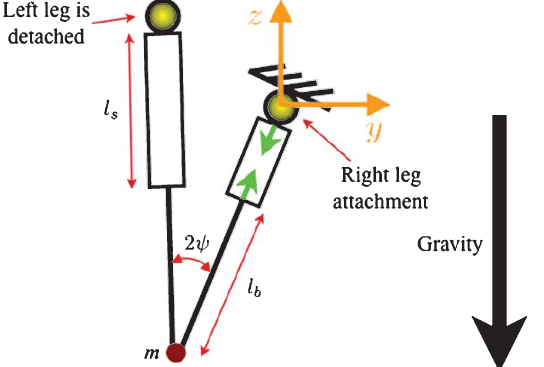
Fig. 1. Mid-stride for the body-switched model. The right foot is attached and serves as a frictionless pivot while the right leg is short- ening, while the left foot is detached and its actuator is extended to its maximum length awaiting the next stride.